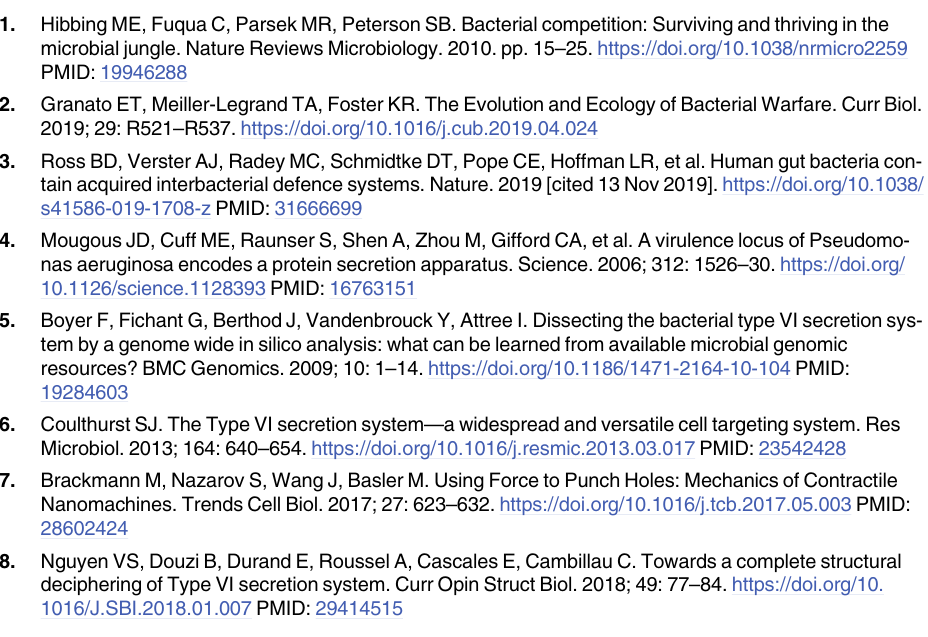
S3 Table. Bacterial strains used in this study.